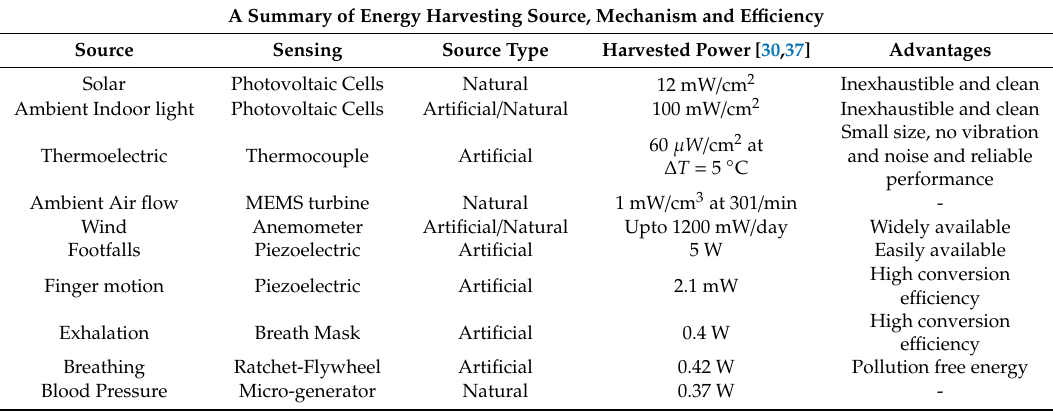
Figure 2. Energy harvesting system with components architecture. Table 1. Energy harvesting sources and their mechanisms [30].